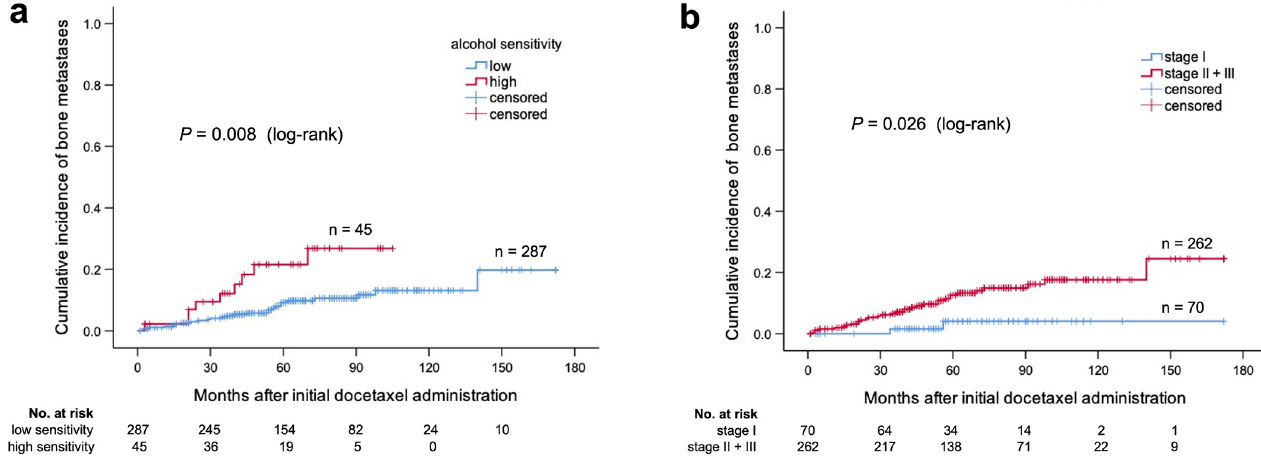
Fig 2. Cumulative incidence of bone metastases by alcohol sensitivity and clinical stages. (a) Cumulative incidence of bone metastases by alcohol sensitivity. (b) Cumulative incidence of bone metastases by clinical stage (stage I vs. stages II and III). The number below each figure is the number of patients at risk.